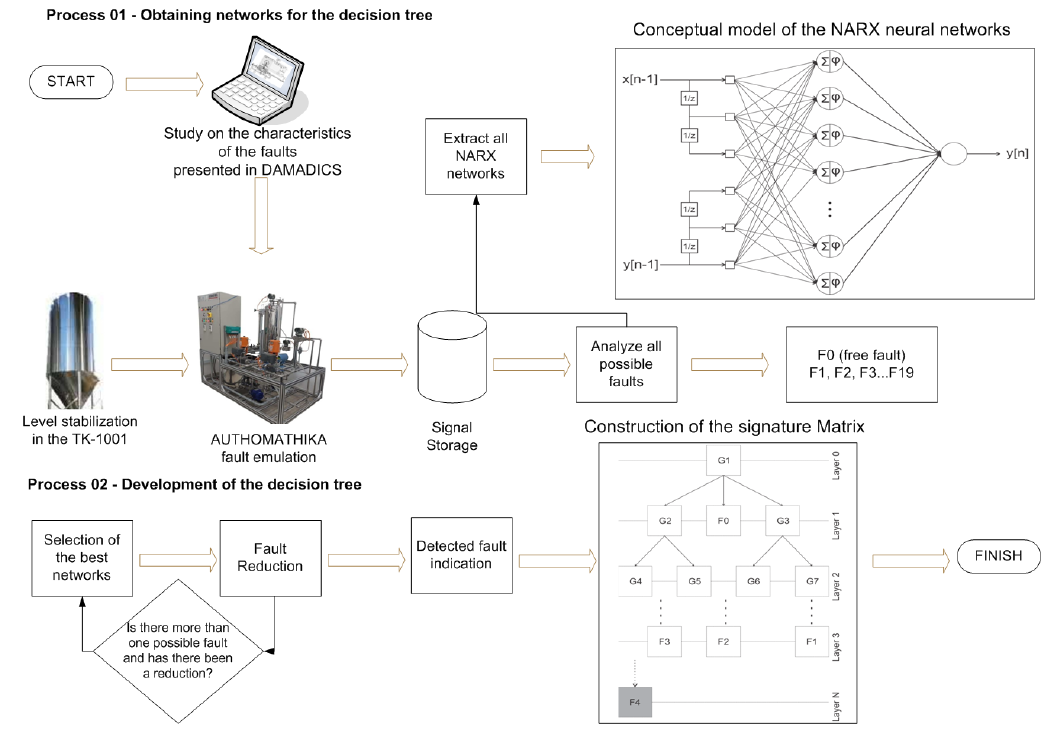
Figure 1. General flowchart of the methodology developed, applied to the study of faults for pneumatic control